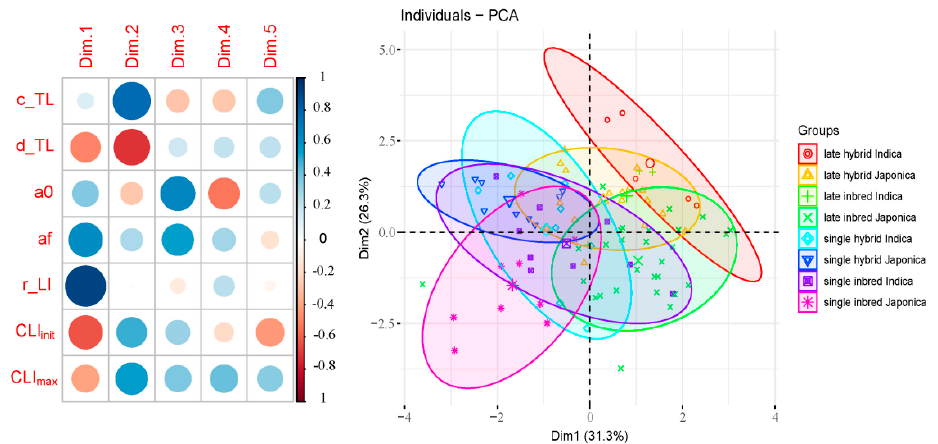
Figure 6. PCA for tillering and canopy light interception characteristic traits among the tested cultivars.